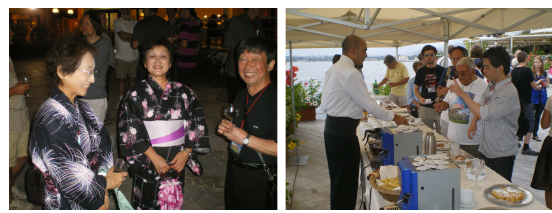
Figure 1: The Japanese delegation wearing traditional kimono during the welcome reception (left). The deli- cious Italian coffee served during the coffee breaks at the hotel terrace (right).